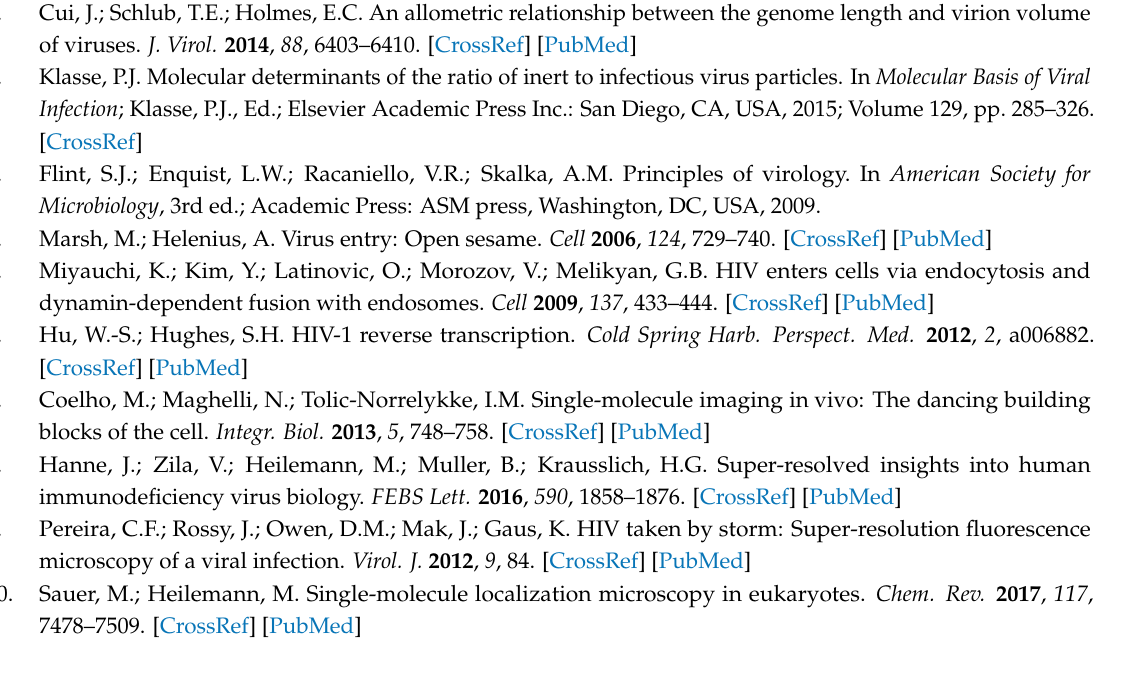
Figure S1: Modalities of wide-field microscopy, Figure S2: Continuous-wave confocal imaging microscopy, Figure S3: Pulsed interleaved excitation confocal imaging